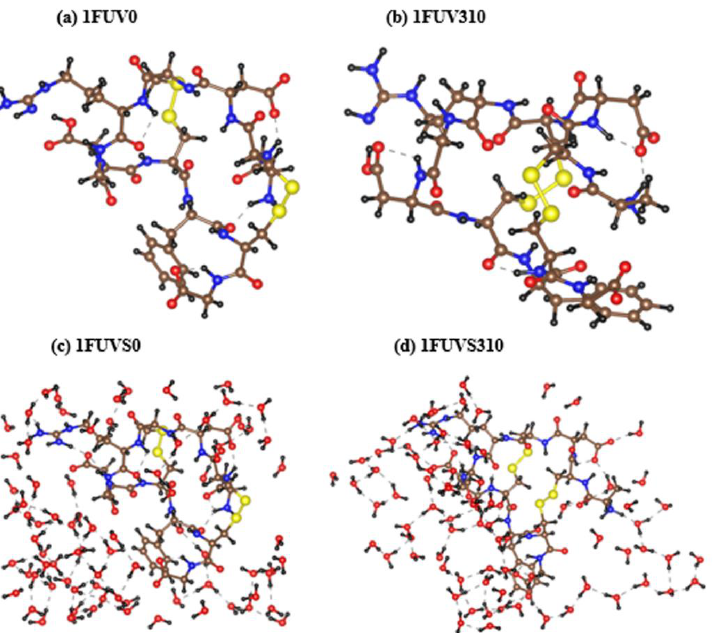
Figure 2. Structures of dry ( a , b ) and solvated ( c , d ) 1FUV peptide at 0 K and 310 K, respectively. (N = Blue, C = Brown, O = Red, H = Black, and S = Yellow).